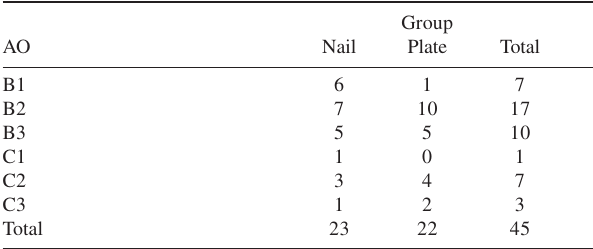
Table 2 - Distribution of patients per group and according to the AO classification